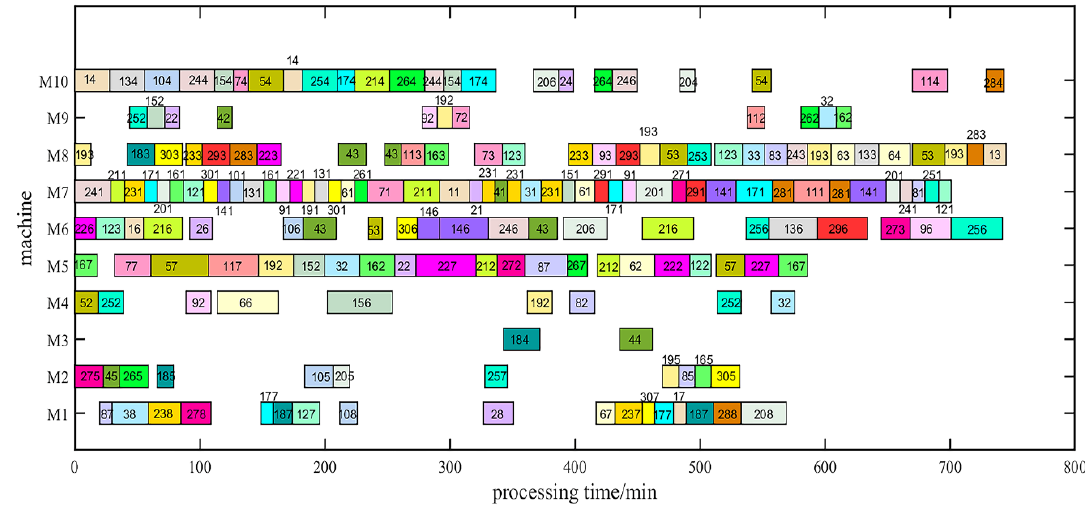
Figure 13. Gantt chart of